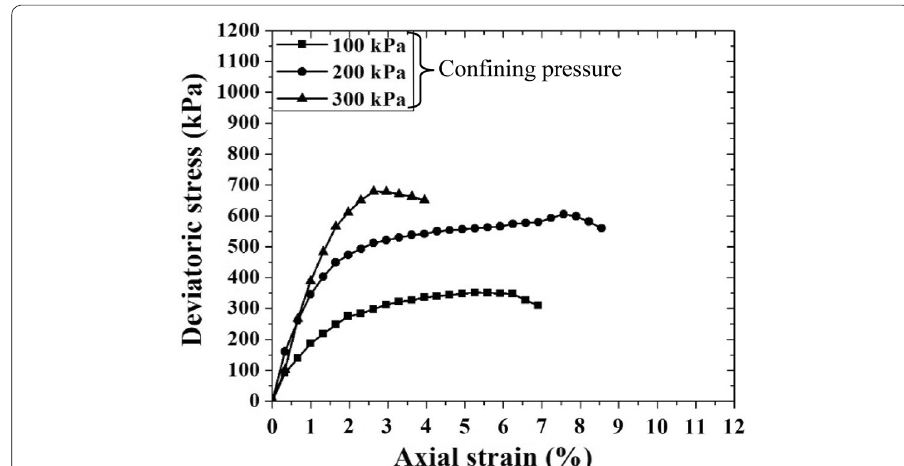
Fig. 30 Stress strain behavior of Borabanda MSW at RC-98%